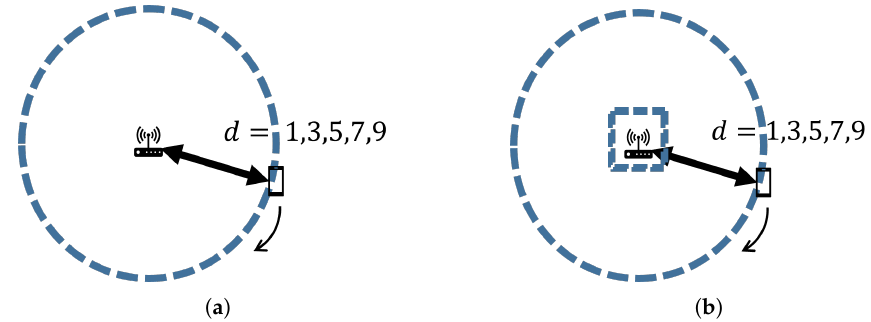
Figure 5. Schematic of the RFPV environment: ( a ) LOS condition; ( b ) NLOS